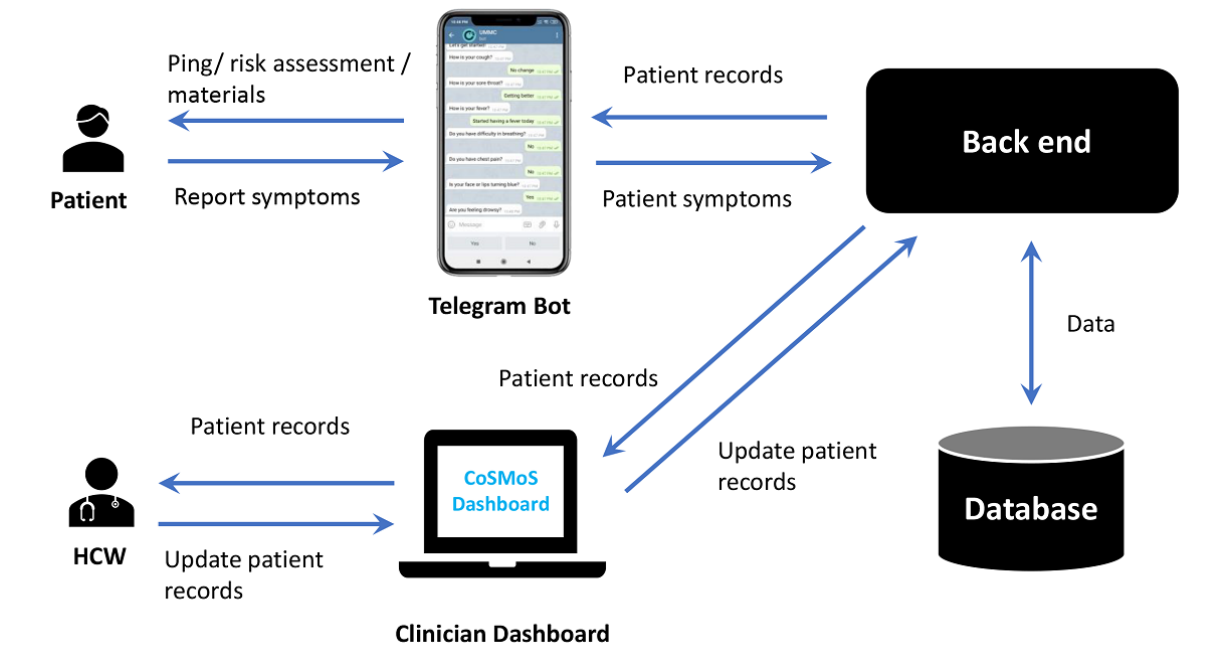
Figure 2. System architecture of the COVID-19 Symptom Monitoring System (CoSMoS). HCW: health care